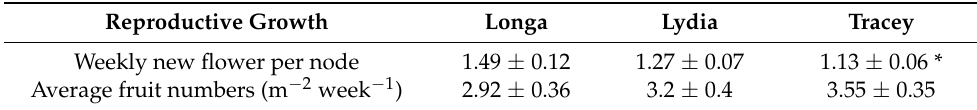
Table 1. Flower and fruit number of Eggplant varieties in a high-tech greenhouse. Data are mean ± SE (n =